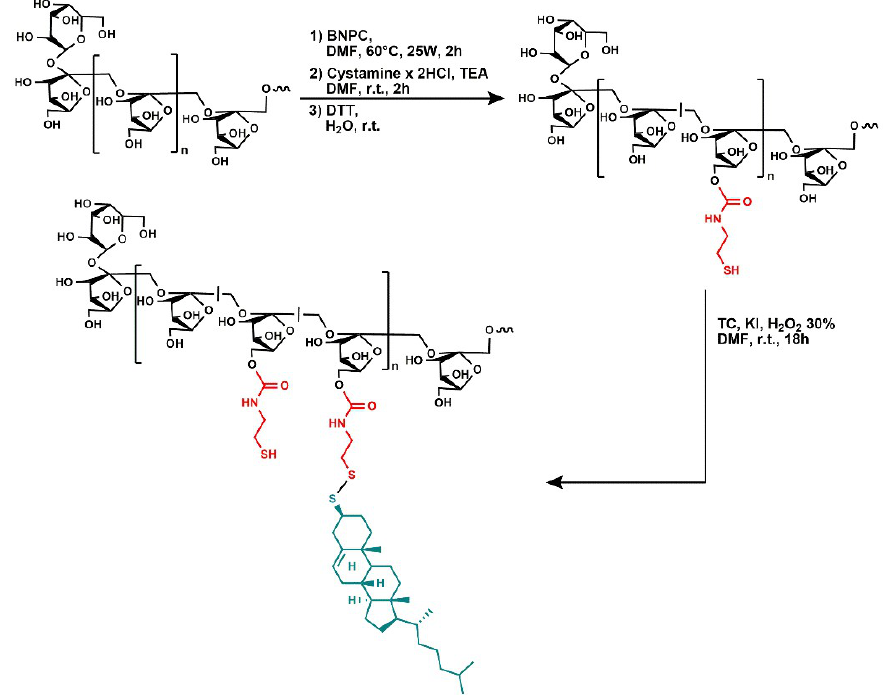
Figure 1. Schematic representation of the synthesis of INU-Cys-TC. In the first step, cytamine is first introduced as side pendants to be reduced, giving rise to cysteamine side groups. Finally, cholesterol groups were coupled by bio-reducible disulfide bonds.